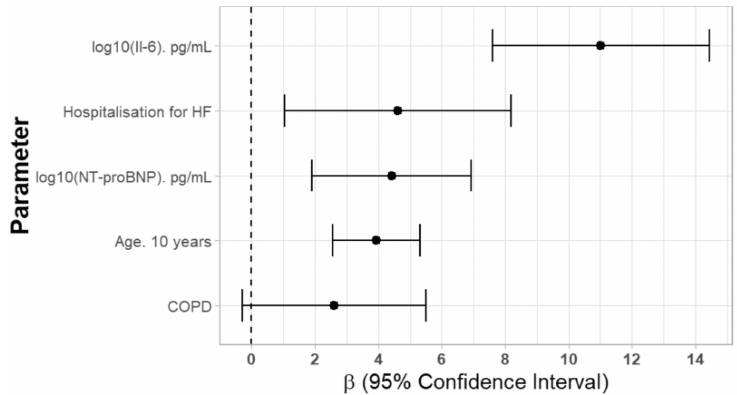
Figure 2. Independent factors a ff ecting serum CA125 concentrations. Abbreviations: Il-6—interleukin 6, HF—heart failure, COPD—chronic obstructive pulmonary